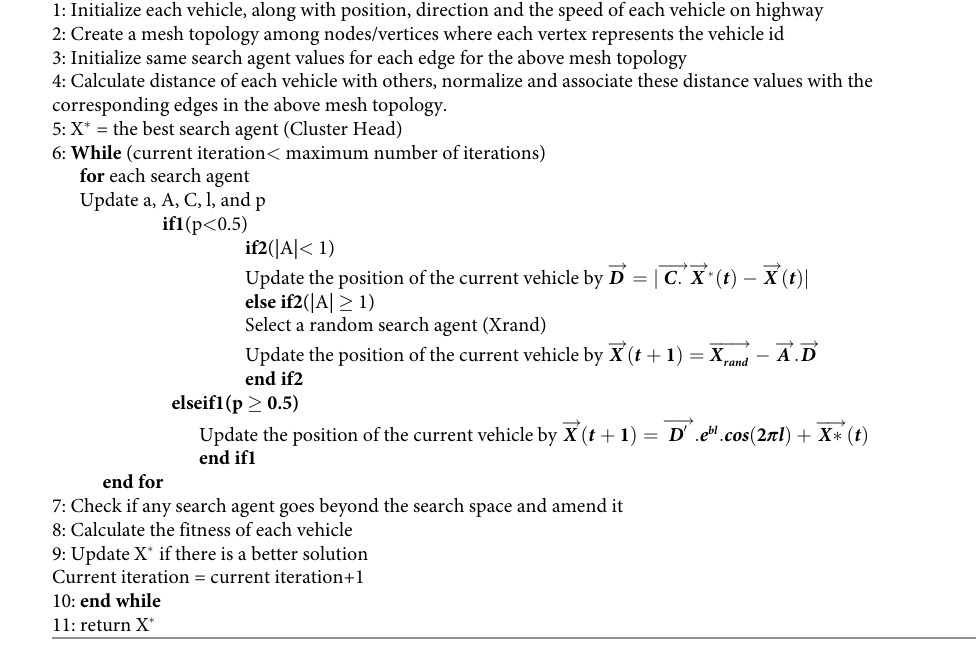
Pseudocode of developed